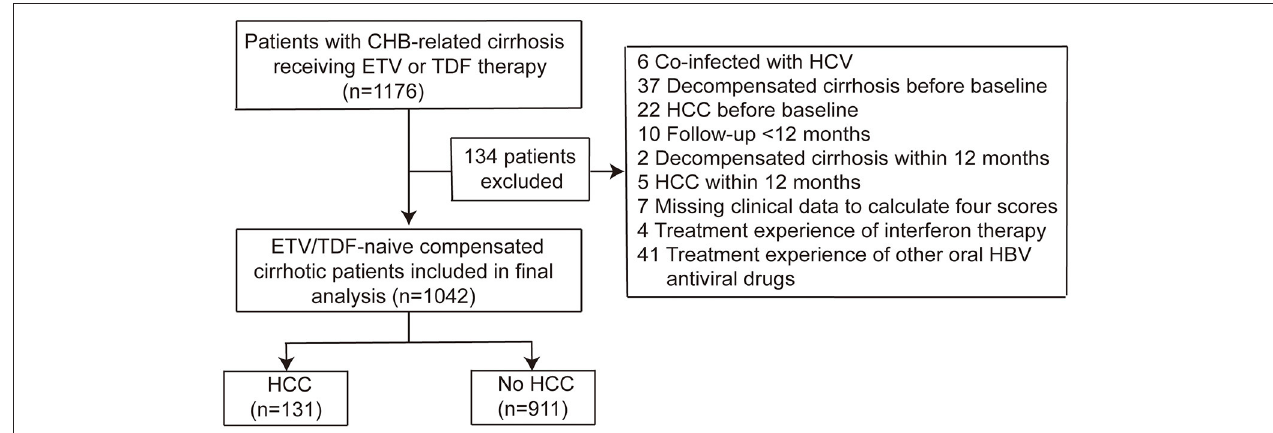
FIGURE 1 | Flow chart of patients with chronic hepatitis B-related cirrhosis receiving ETV or TDF therapy.